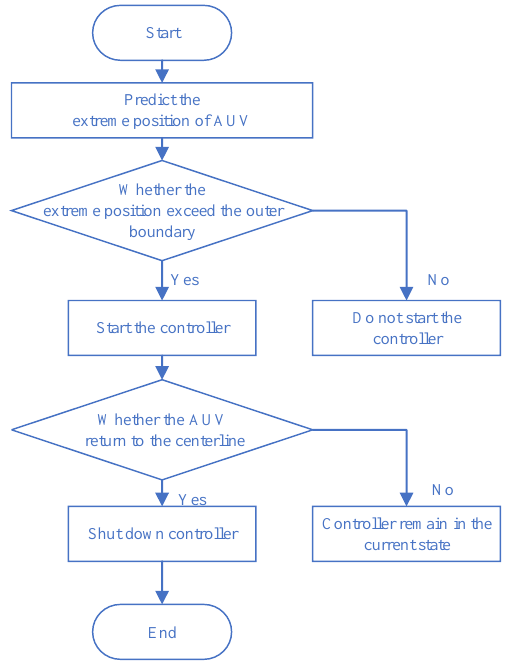
Figure 2. Flow chart of the PRTC scheme.